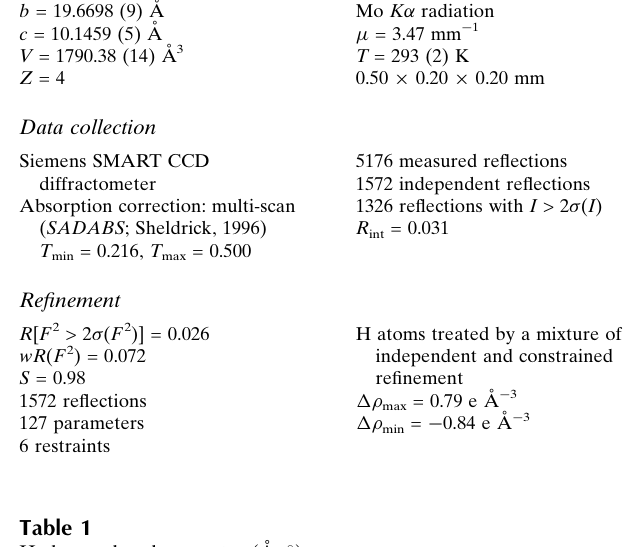
Hydrogen-bond geometry (A˚ , (cid:3)